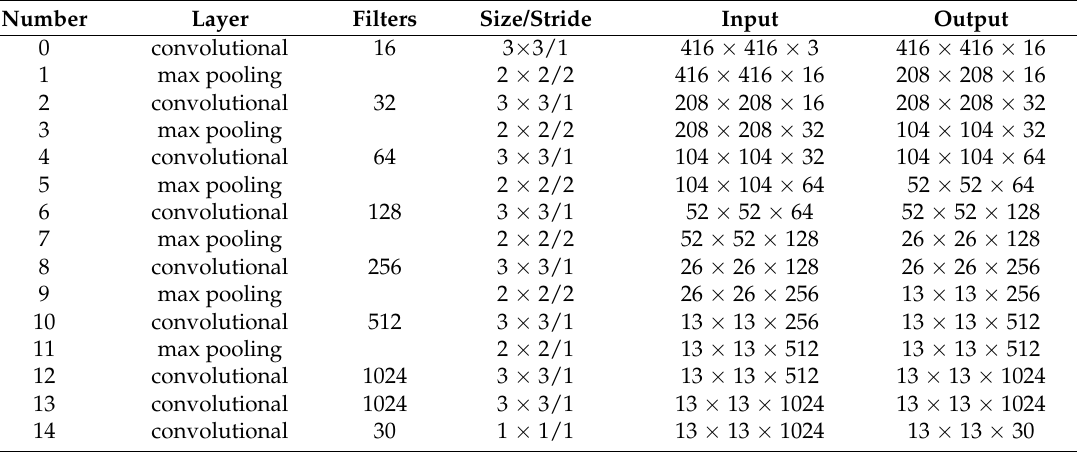
Table 1. Feature Map Generation includes the input and output of each